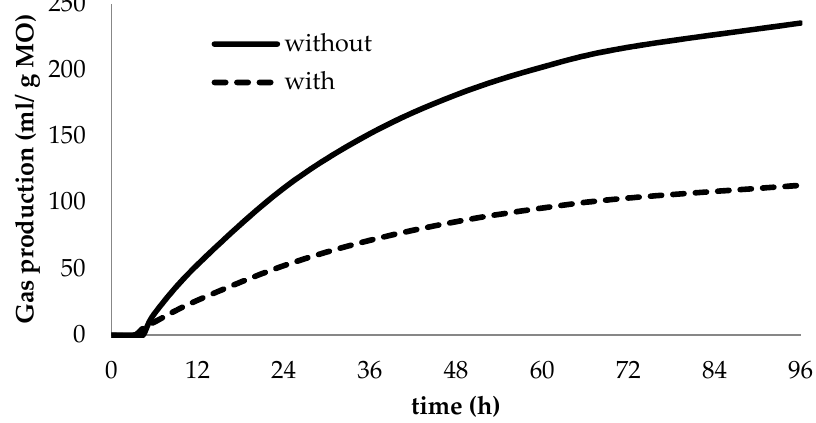
Figure 1. Effects of condensed tannin in diet (with and without) on gas production profiles during in vitro rumen fermentation (pooled over ruminant species).